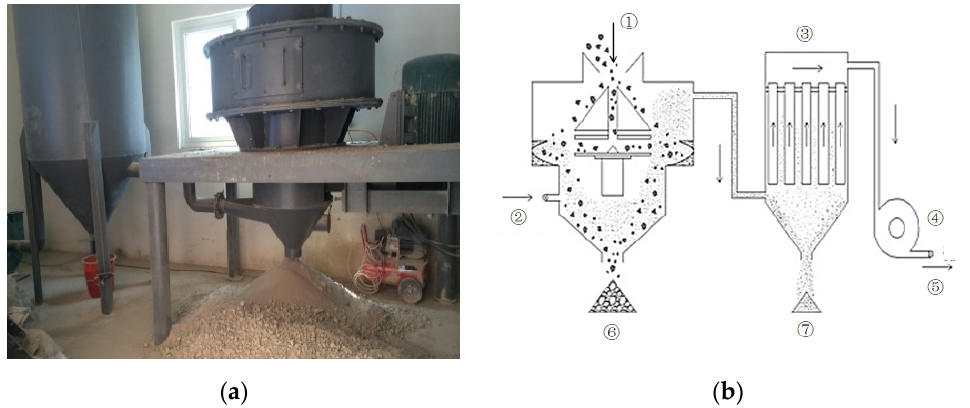
Figure 1. Particle-shaping strengthening equipment and working principle: ( a ) equipment ap- pearance and ( b ) working principle. Note: ① raw material, ② air inlet port, ③ dust collector, ④ induced draft fan, ⑤ air outlet port, ⑥ granular plastic regenerated aggregate, and ⑦ recycled powder.